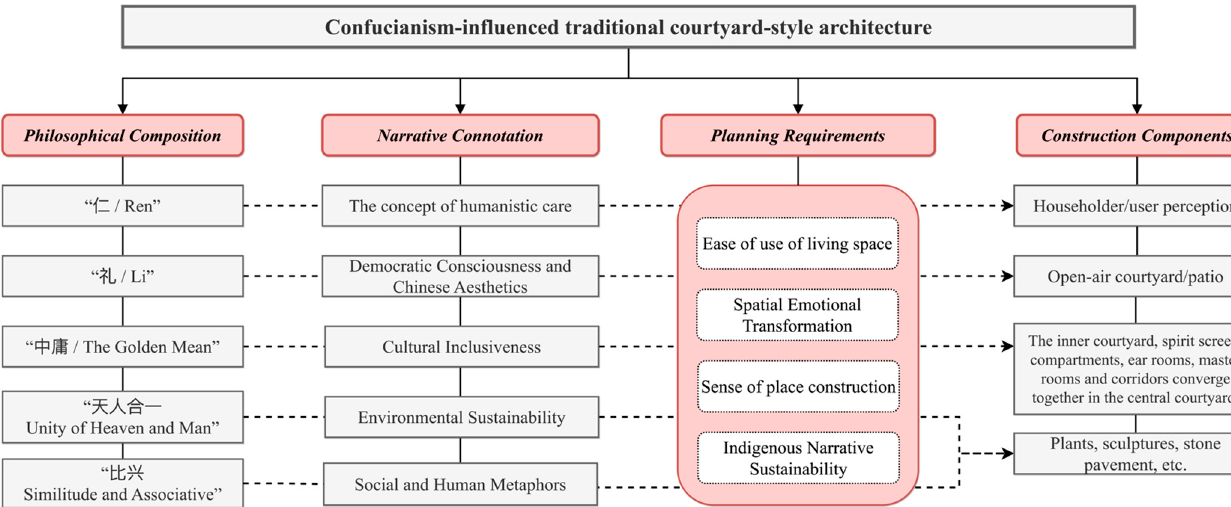
Figure 8. The shrine of expecting good wind and rain. Photo by W. Rong.